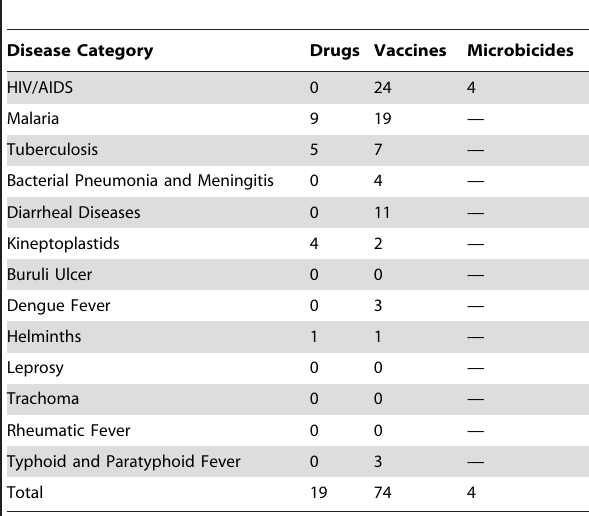
Table 4. Neglected Disease Products in Clinical Development as of July 2009.